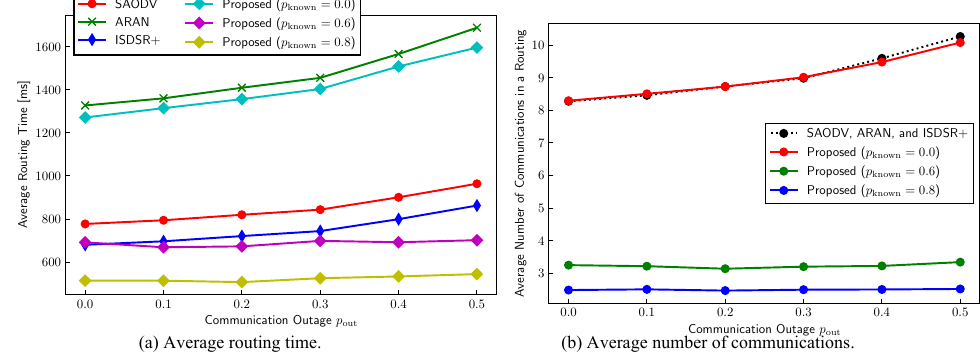
Figure 10. Effects of outage probability on average routing time (30 relay nodes).